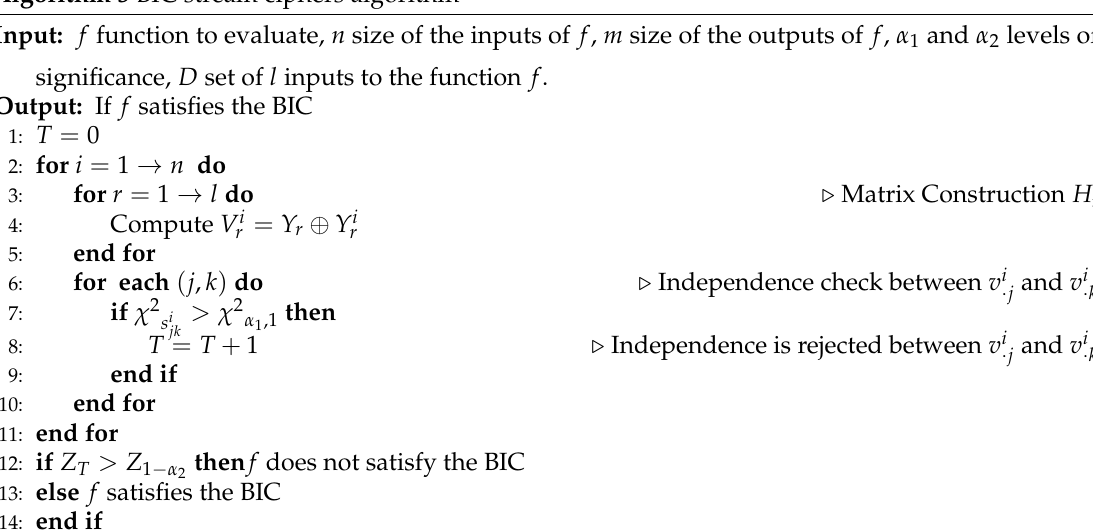
Algorithm 3 BIC stream ciphers